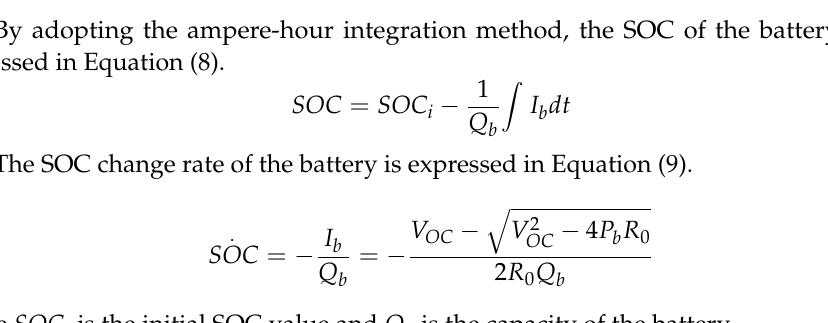
Figure 4. The battery of discharging/charging internal-resistance diagrams. ( a ) Discharge; ( b ) Charge. By adopting the ampere-hour integration method, the SOC of the battery can be expressed in Equation